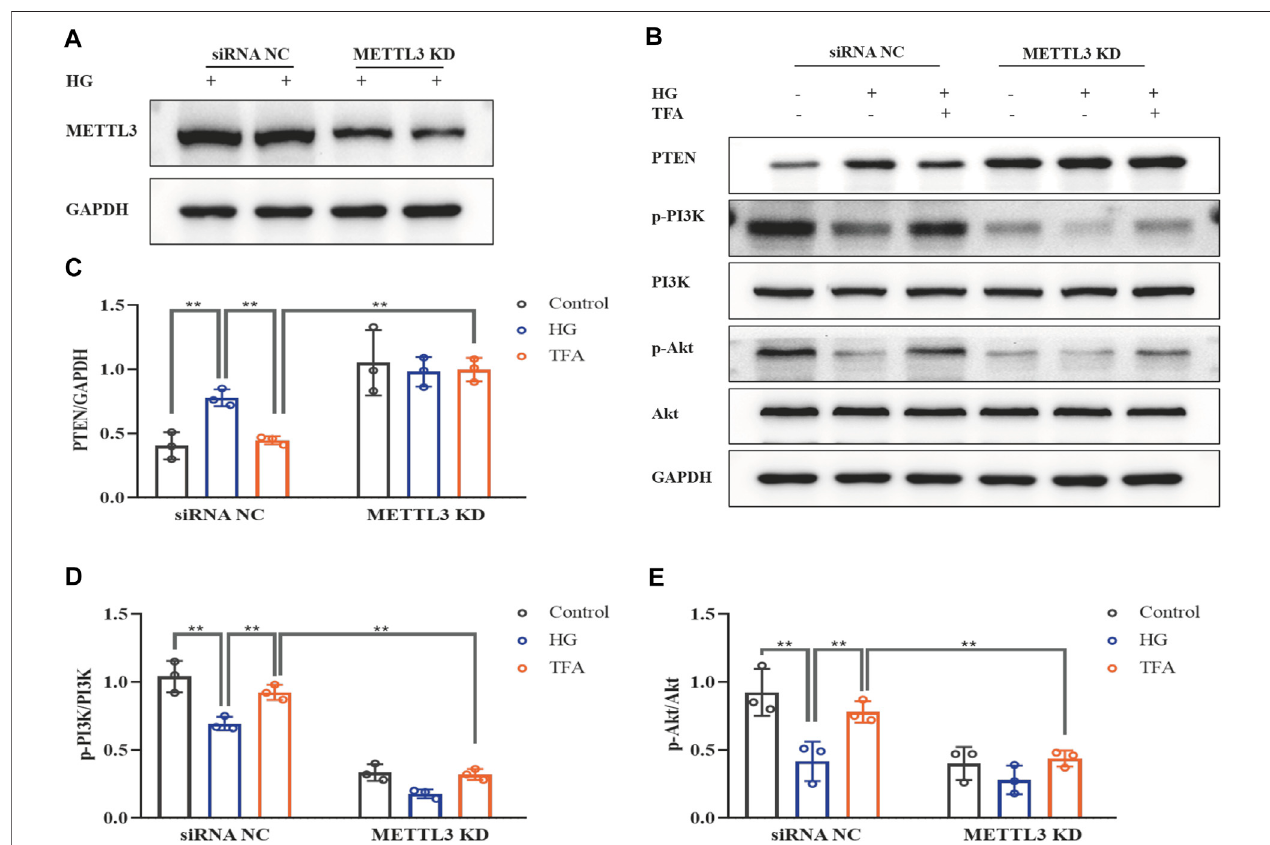
FIGURE 9 | TFA regulated the PTEN/PI3K/Akt signaling pathway in a METTL3-dependent manner via m 6 A modi fi cation in HG-af fl icted MPC-5 cells with knockdown of METTL3. (A) WB analysis of METTL3 in cultured MPC-5 cells transfected in duplicates with a NC siRNA or a METTL3 KD siRNA for 24 h and exposed to HG(30 mM)for48h; (B) WBanalysisofPTEN,p-PI3K,PI3K,p-Akt,andAkt,inculturedMPC-5cellstransfectedwithNCsiRNAorMETTL3KDsiRNAfor24 h,following byexposuretoHGat30 mMfor48 hwithorwithoutTFA(20 μ g/ml)for24 h; (C) PTENwasquanti fi edbydensitometry; (D) p-PI3Kwasquanti fi edbydensitometry; (E) p-Aktwasquanti fi edbydensitometry.Dataareexpressed asmean ± S.D.,( n (cid:2) 3).* p < 0.05,** p < 0.01.Abbreviations:TFA, total fl avonesof Abelmoschus manihot ; PTEN, phosphate and tension homology; PI3K, phosphatidylinositol 3-kinases; Akt, protein kinase B; METTL, methyltransferase-like; m 6 A, N6-methyladenosine; HG, high glucose; MPC-5, mouse podocyte cell-5; WB, western blotting; NC, negative control; siRNA, small interfering RNA; KD, knockdown; p-PI3K, phosphorylated- phosphatidylinositol 3-kinase; p-Akt, phosphorylated-protein kinase B.